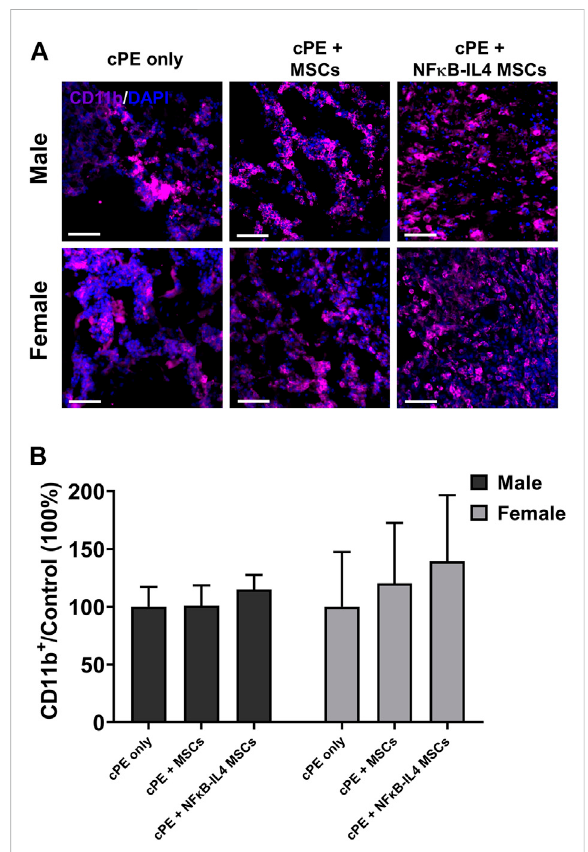
FIGURE 6 Immuno fl uorescent (IF) staining analysis for CD11b + cells in each group. (A) representative images of Immuno fl uorescent for CD11b + cells (Purple). Scale bar = 50 μ m. (B) quantitative analysis of the ratio changes of CD11b + cell compared to sex- matched control group. The CD11b + cells showed an increased trendafter celltreatmentinMSCs and NF κ B-IL4 MSCs groups, and no statistical difference was found among groups and sexes. (Males, cPE only group: n = 5, cPE + MSCs group: n = 7, cPE + NF κ B-IL4 MSCs group: n = 5; Females, cPE only group: n = 5,